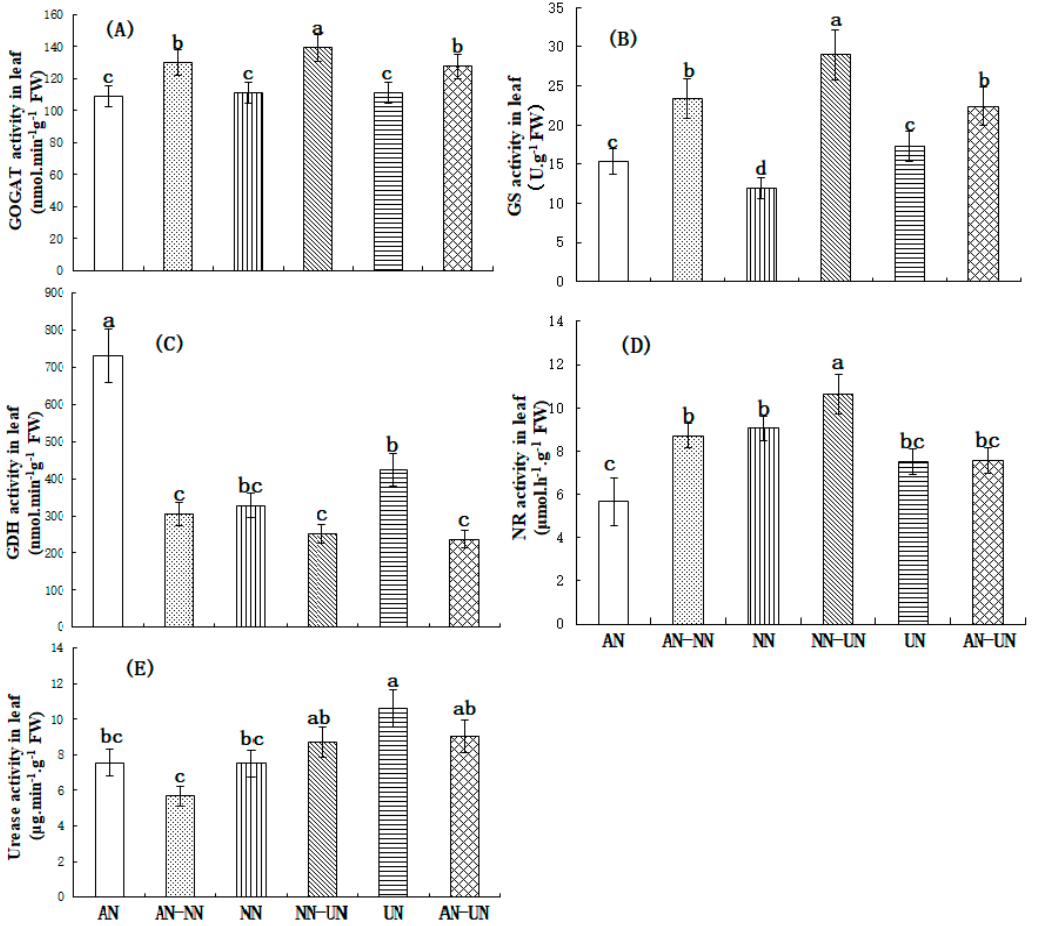
Figure 3. E ff ect of di ff erent nitrogen forms on nitrogen-metabolizing enzymes in cucumber. ( A ) GOGAT Figure 3. Effect of different nitrogen forms on nitrogen-metabolizing enzymes in cucumber. A . activity; ( B ) GS activity; ( C ) GDH activity; ( D ) NR activity; ( E ) Urease activity. Bars represent the GOGAT activity; B . GS activity; C . GDH activity; D . NR activity; E . Urease activity. Bars represent the standard error. Di ff erent letters above the bars indicate significant di ff erences at p < 0.05 according to standard error. Different letters above the bars indicate significant differences at p < 0.05 according to Tukey’s multiple comparison Tukey’s multiple comparison test.